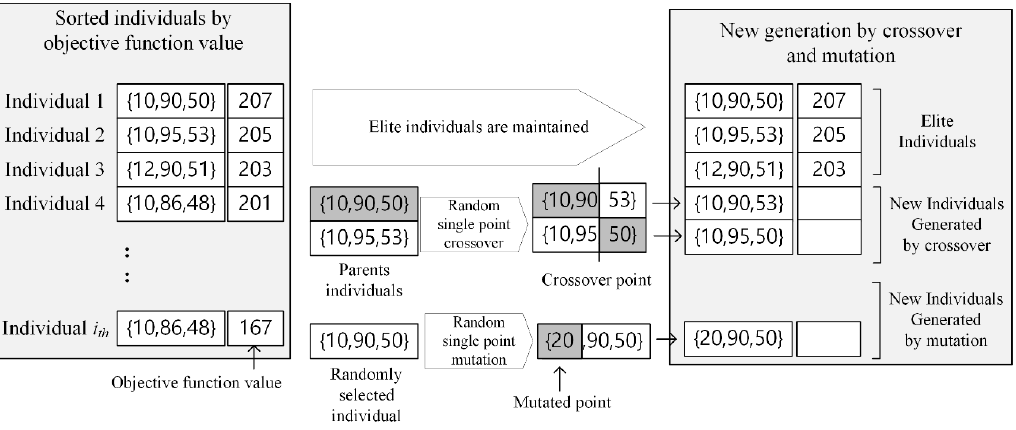
Figure 7. Crossover and mutation operation process.